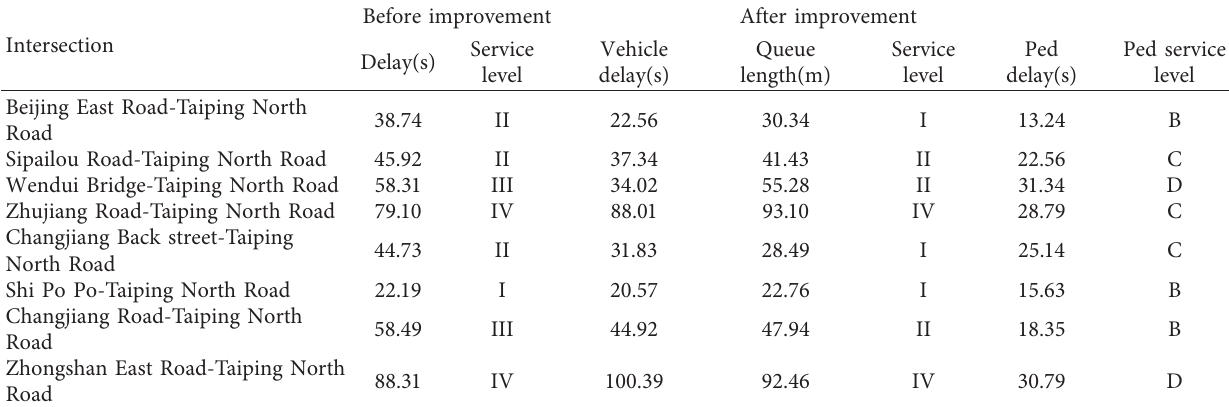
Table 4: Simulation results compared with actual situation.